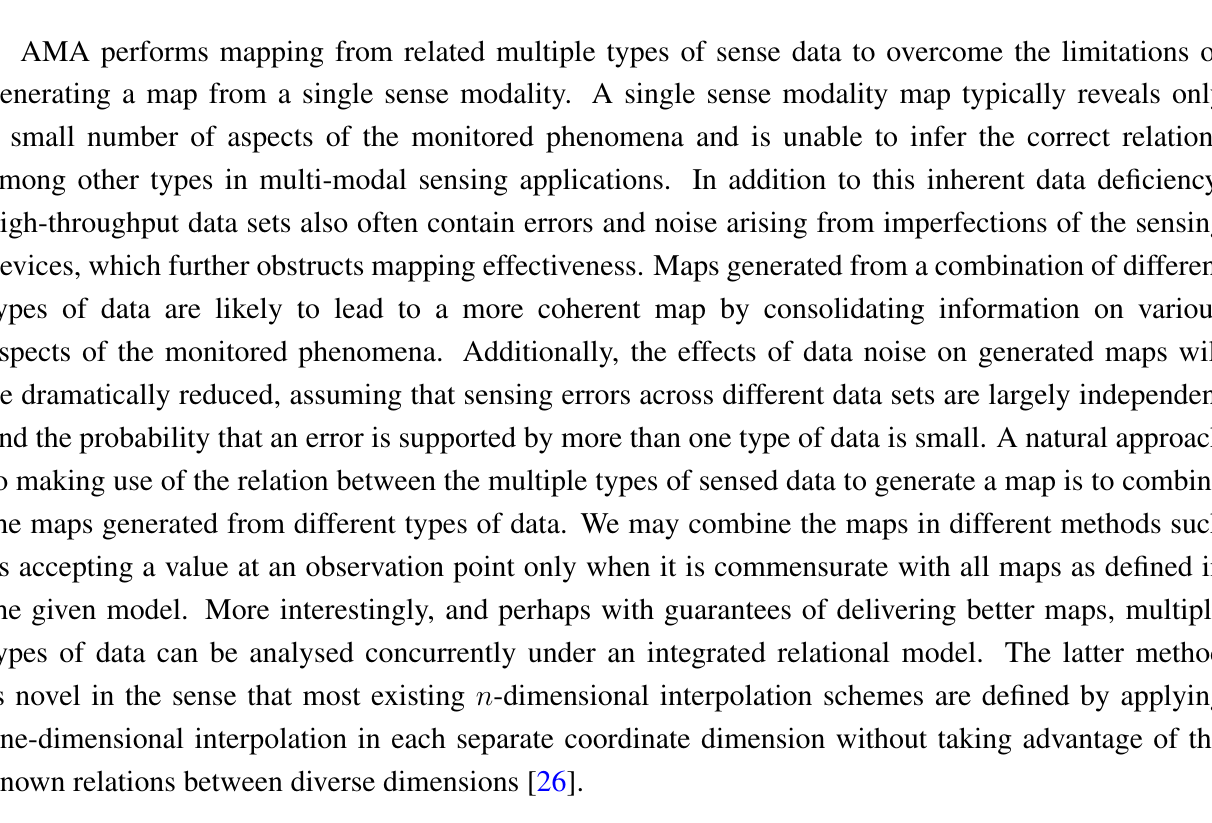
Figure 3. The process of building the domain model by deductive and inductive